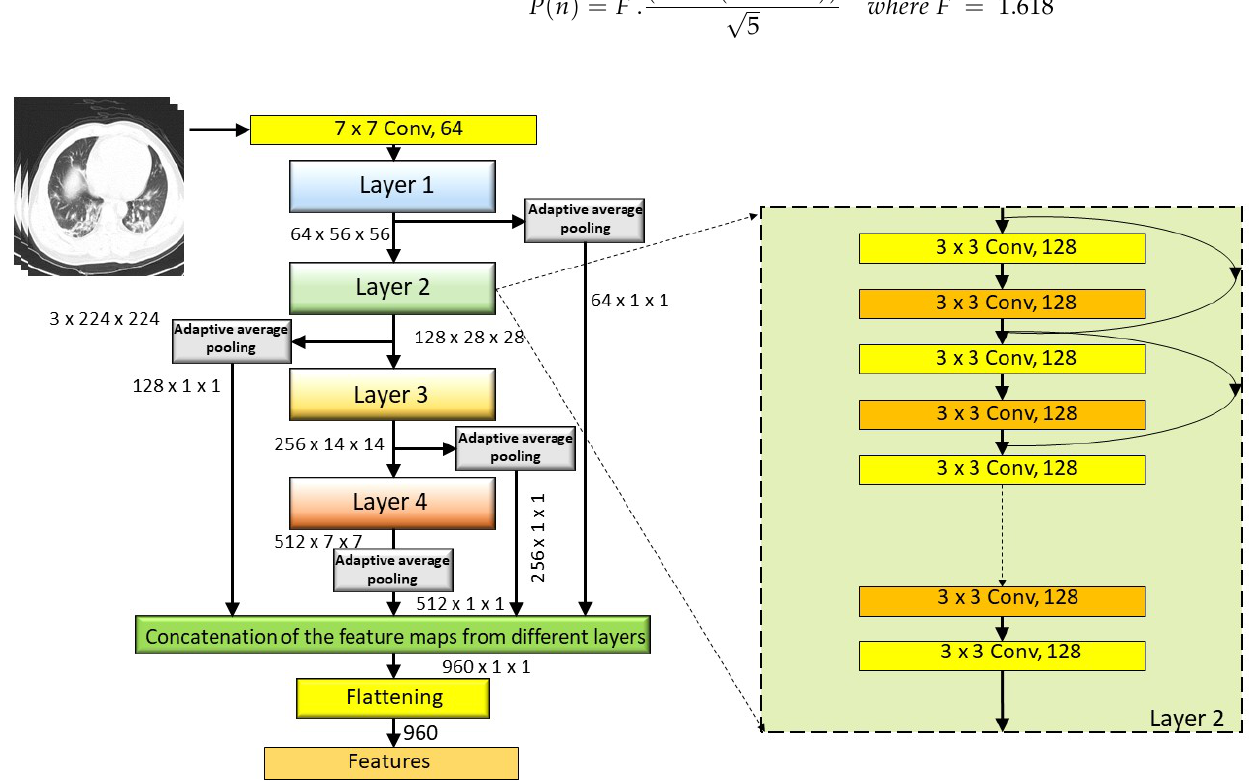
Figure 4. Pictorial representation of our proposed approach of deep feature extraction from fine tuned ResNet18